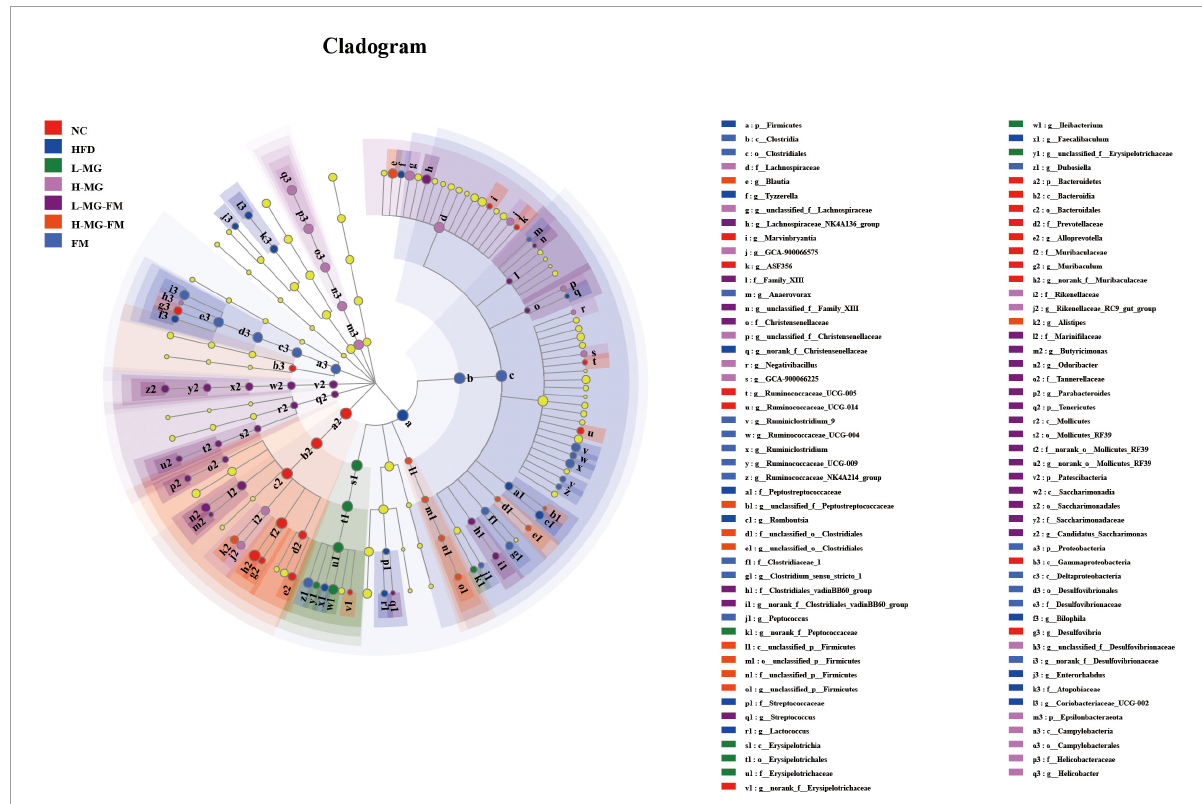
FIGURE5 LEfSe analysis. Cladogram showing the evolutionary relationship between taxa that are differentially abundant between groups, where the threshold of the log (linear discriminant analysis) LDA score was set as 2 ( n =